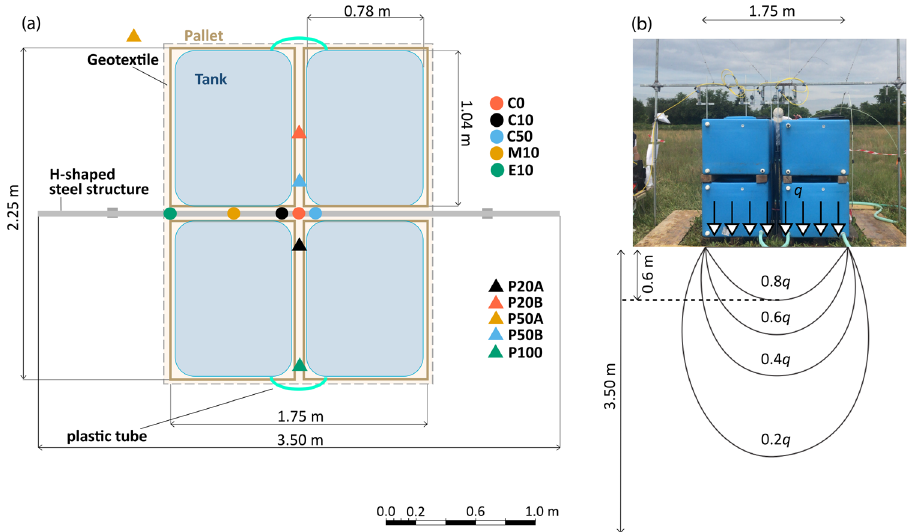
Fig. 1 Design of the loading experiment. a Plan view with dimensions, equipment (tanks, pallet, reference steel structure), location of the sensors to measure vertical displacements (bullets) and pore-water pressure (triangles). The sensor coding is representative of the deployment depth (in cm). b Qualitative contours of effective stress distribution under a square area loaded by q according to the linear theory of elasticity 50 . In a homogeneous soil the effective stress propagates to a depth twice the square side. The value 80% q propagates to a depth less than one third of the width, that is ∼ 0.6 m for the speci fi c